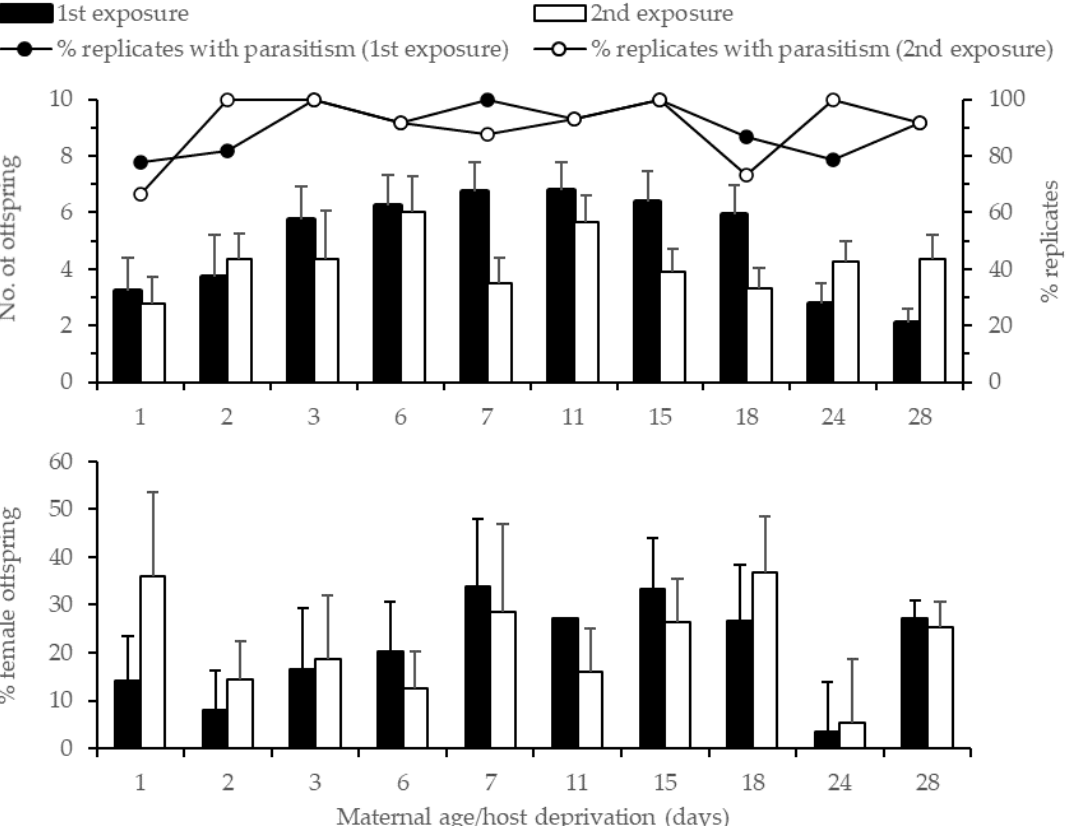
Figure 2. Percent replicates with parasitism, average number of offspring produced ( top ), and offspring sex ratio ( bottom ) ± SE of host-deprived G. aetherium females when exposed to 20 B. hilaris eggs for 3 h and 2 d consecutively.